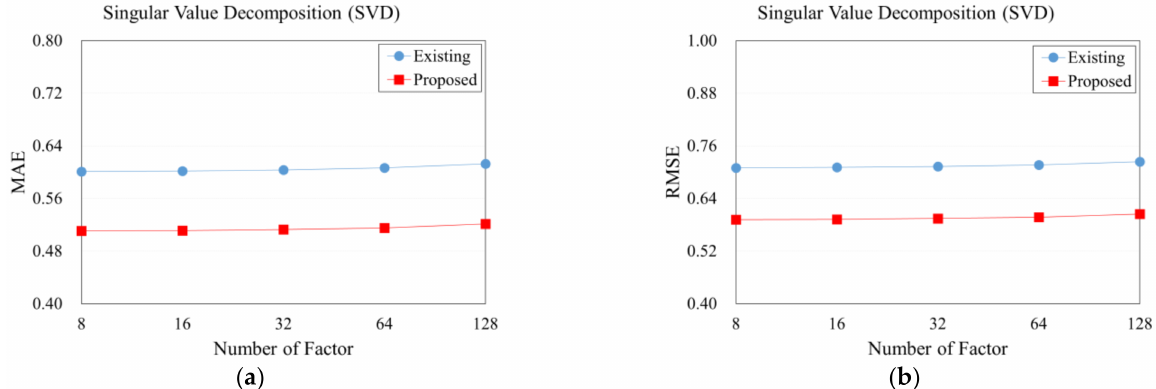
Figure 7. Prediction performance of MAE ( a ) and RMSE ( b ) of SVD